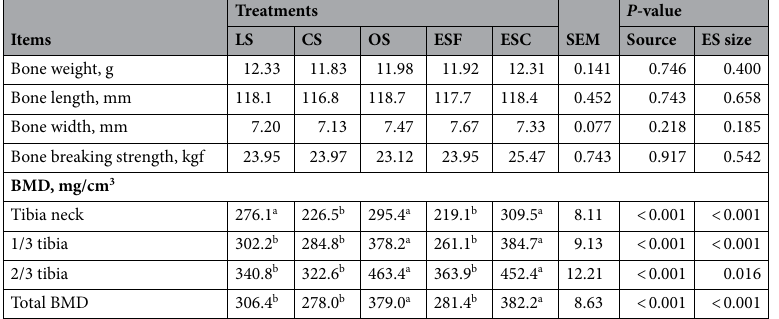
Table 4. Tibia bone quality traits of laying hens at 80 week of age according to the treatments. Results are the means of 16 hens at 80 wk of age. LS limestone (< 2 and 2–4 mm mixed in 3:7); CS cockle shell (1–4 mm), OS oyster shell (3–16 mm); ESF eggshell fine particles (< 1 mm); ESC eggshell coarse particles (3–5 mm). SEM standard error of means, ES eggshell, BMD bone mineral density. a,b Means with the different superscript in the same row differ significantly ( P <